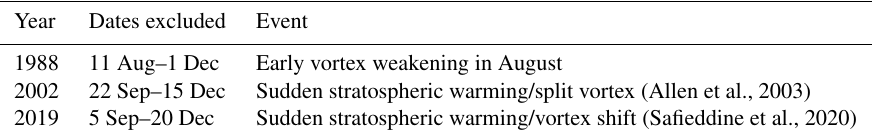
Figure 2. Selected ozonesonde profiles from 2019–2021 representing the ozone hole severity over the South Pole by comparing the average winter profile before depletion begins (blue line) to the minimum-ozone profile (red line). The minimum total column ozone (TCO) and 14–21km (dashed horizontal line region) partial column ozone values are given in Dobson units (DU). The gray shaded region represents the 1986–2018 median 30–70th percentiles for winter and minimum periods. The record low of 92DU TCO measured in 2006 is shown as a dotted line in the 2019 graph. The temperature graphs show the − 78 ◦ C PSC threshold as a dashed vertical line. Table 1. Years when an early disruption of the polar vortex was observed over the South Pole and the corresponding period when the profile data were excluded from the ozonesonde median and percentile